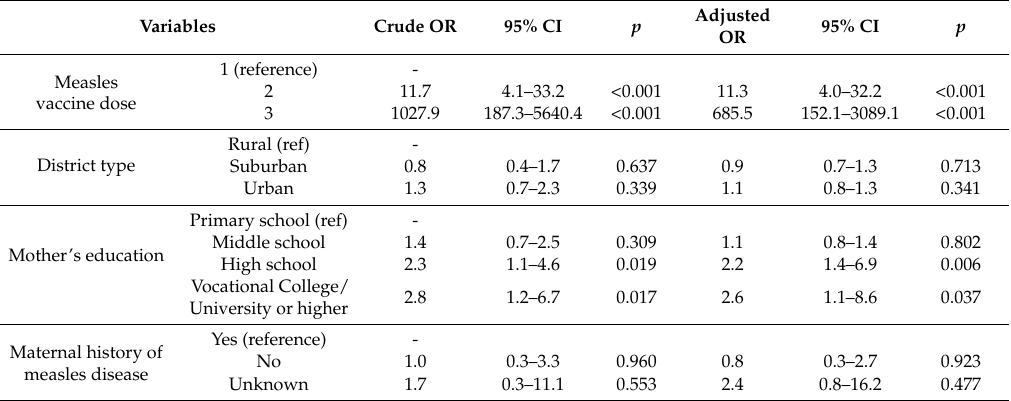
Table 3. Demographic and other predictors of measles antibody seropositivity among healthy children: a multivariable logistic regression